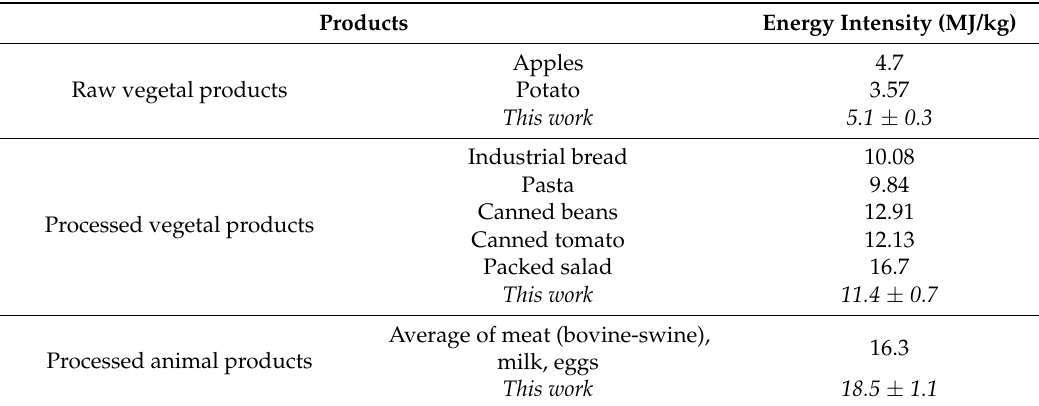
Table 5. Comparison between results on FSC energy intensity from the present work (without the distribution segment) and selected data from Italian Environmental Product Declarations.